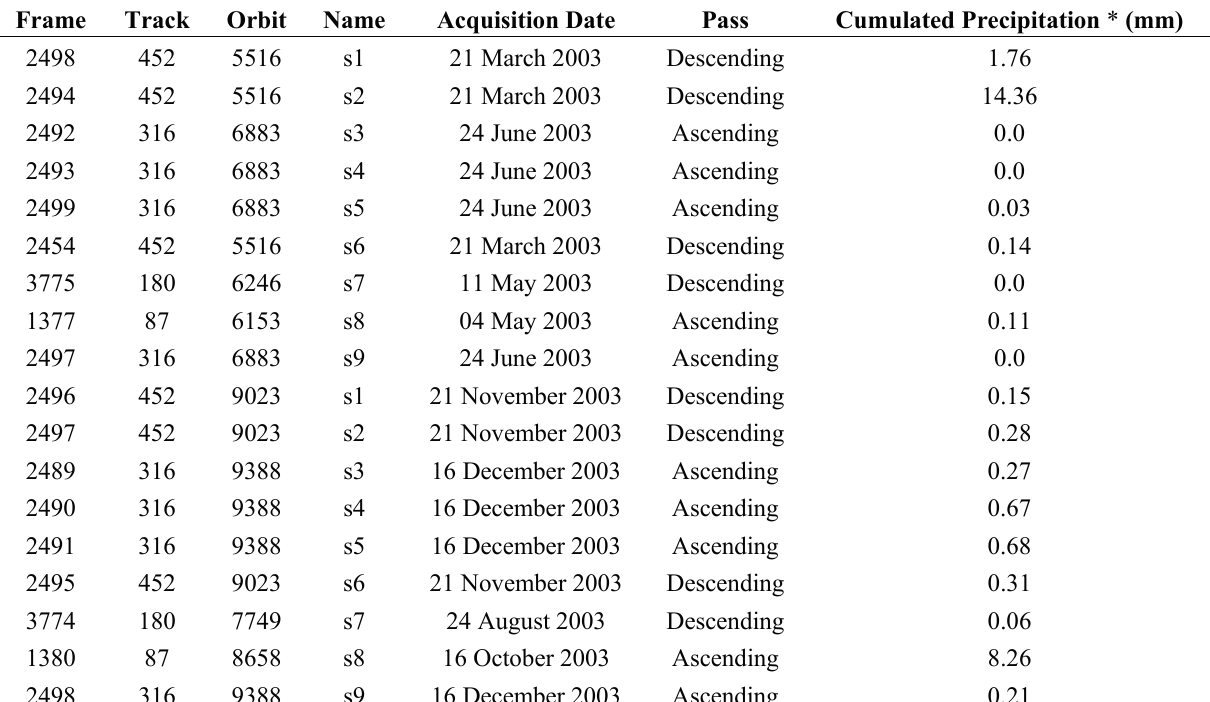
Table 2. SAR data set and pertinent rainfall